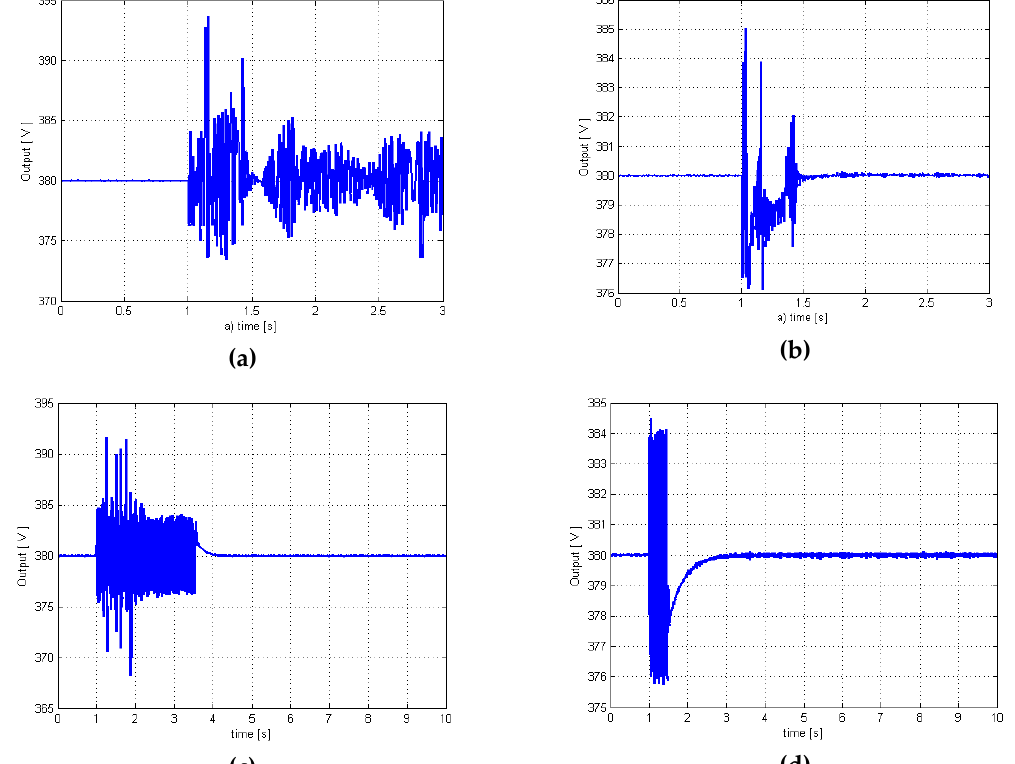
Figure 11. ( a ) Controlled output—classical minimum variance controller (( ρ = 0.1, ∆ T m = 24% ) , high Figure 11. (a) Controlled output—classical minimum variance controller (( (cid:2025) = 0.1, (cid:1986)(cid:1846) (cid:3040) = 24%) , disturbance)—unstable system; ( b ) Controlled output—the proposed minimum variance controller ( ρ ∈ { 0.0001, 0.1, ∆ T m = 24%—high disturbance); ( c ) Controlled output—classical PID controller high disturbance)—unstable system; (b) Controlled output—the proposed minimum variance ( ∆ T m = 24% - high disturbance); ( d ) Controlled output—adaptive PID controller retuned ( ∆ T m = 24% - controller ((cid:2025) ∈ {0.0001, 0.1, (cid:1986)(cid:1846) (cid:3040) = 24% —high disturbance); (c) Controlled output—classical PID high controller ( (cid:1986)(cid:1846) (cid:3040) = 24% - high disturbance); (d) Controlled output—adaptive PID controller retuned ( (cid:1986)(cid:1846) (cid:3040) = 24% - high disturbance)